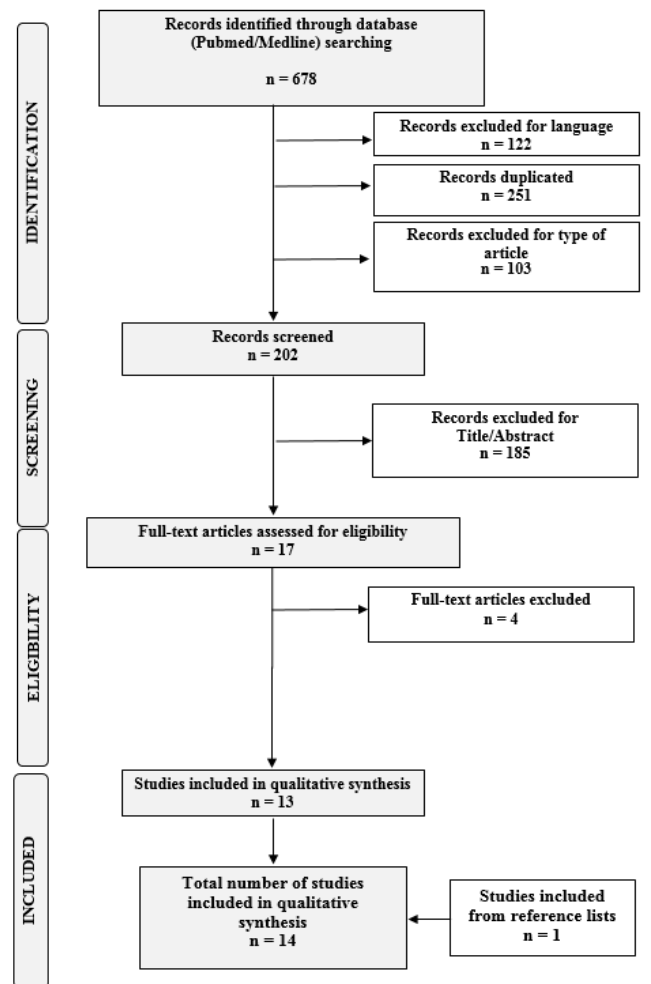
Figure 2. Flow diagram of the search strategy, screening, eligibility, and inclusion criteria.